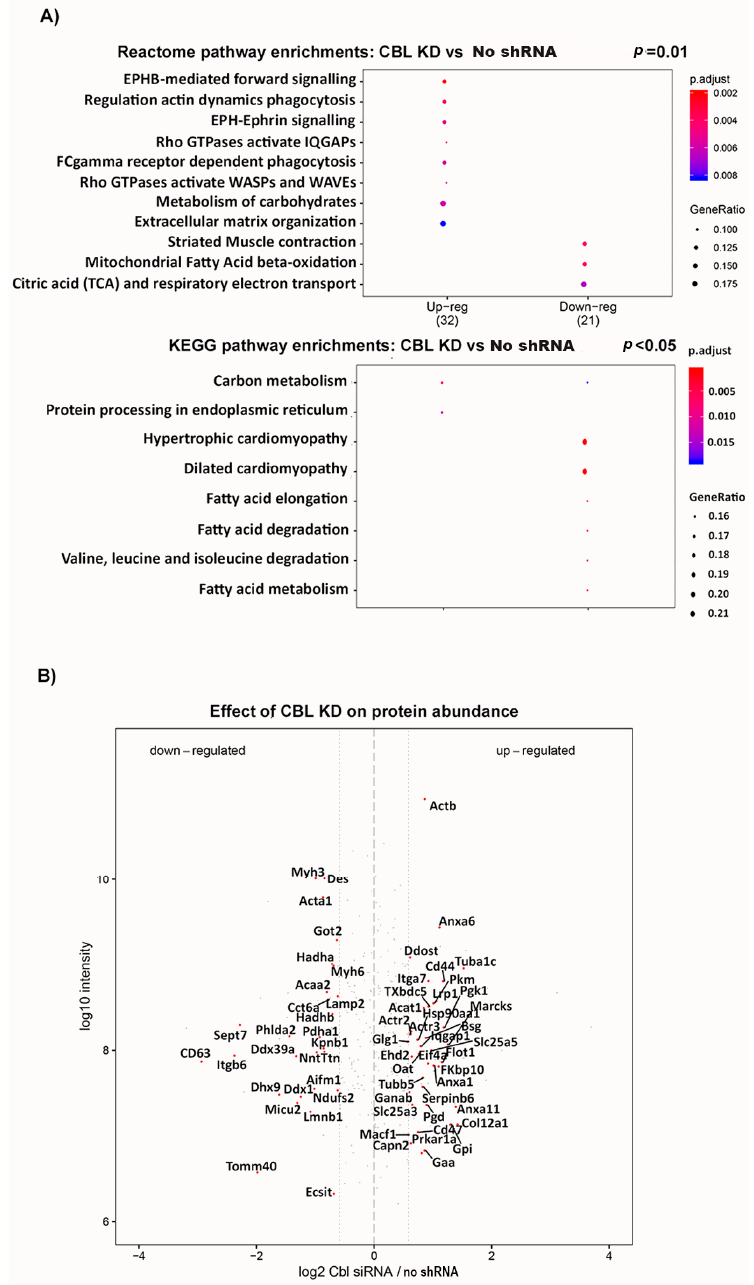
Figure 6. Cbl KD cells have reduced abundance of proteins involved in CI biogenesis and fatty acid degradation, and increased levels of glycolytic enzymes. SILAC-based proteome comparison of CBL KD to untreated control cells. Functional analysis and visualization of data were carried out in R/Bioconductor package v.3.4. All protein hits from the 1% FDR Andromeda search were subsequently used for GO enrichment analysis. ( A ) Reactome and KEGG pathway term enrichment analysis of differentially expressed proteins. ( B ) Relative abundance of differentially expressed proteins. Those highlighted in red show 1.5-fold or greater differential expression.